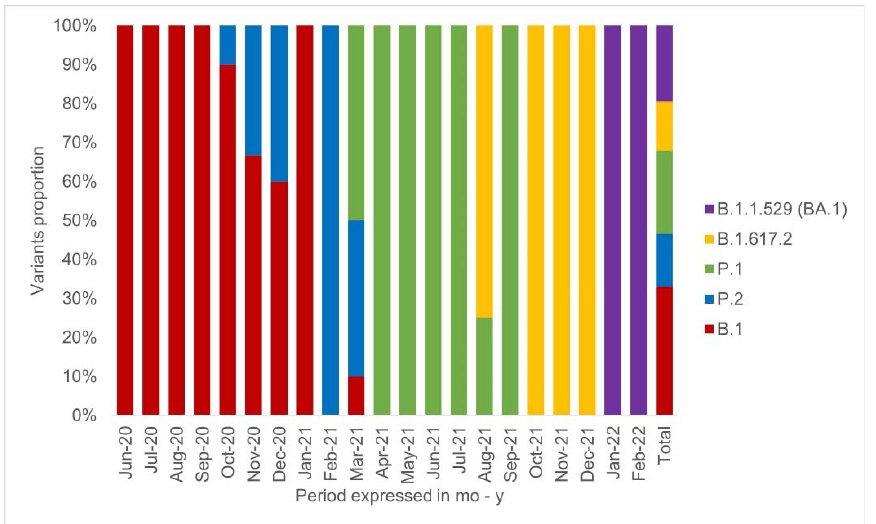
Figure 1. Distribution of studied variants in 2020 to 2022. Distribution of the variants detected in the study period, by month: wild type (B.1) as red, zeta (P.2) as blue, gamma (P.1) as green, delta (B.1.617.2) as yellow, omicron (BA.1) as purple. It can be observed that the B.1 strains and the P.1